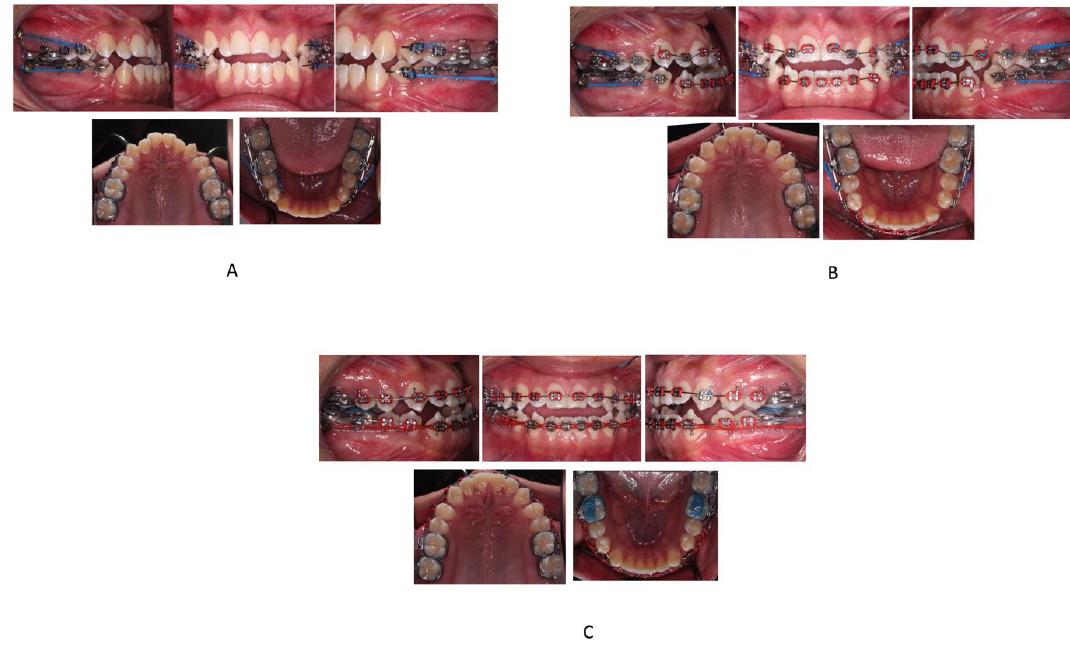
Figure 2. ( A – C )—Progress intraoral Figure 2. ( A – C ) — Progress intraoral photographs.